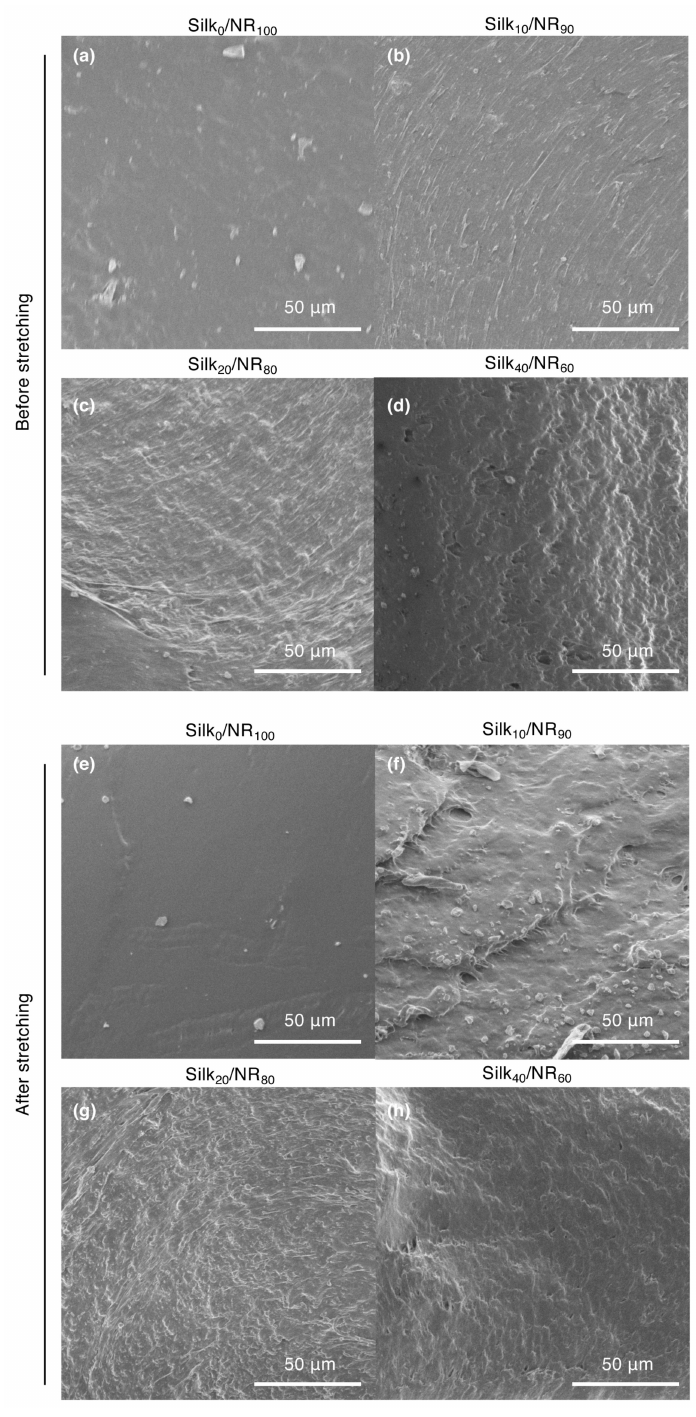
Figure 5. Cross-sectional SEM images of silk / NR composites with di ff erent silk contents. ( a – d ) As-prepared surface before stretching and ( e – h ) the fracture surface after